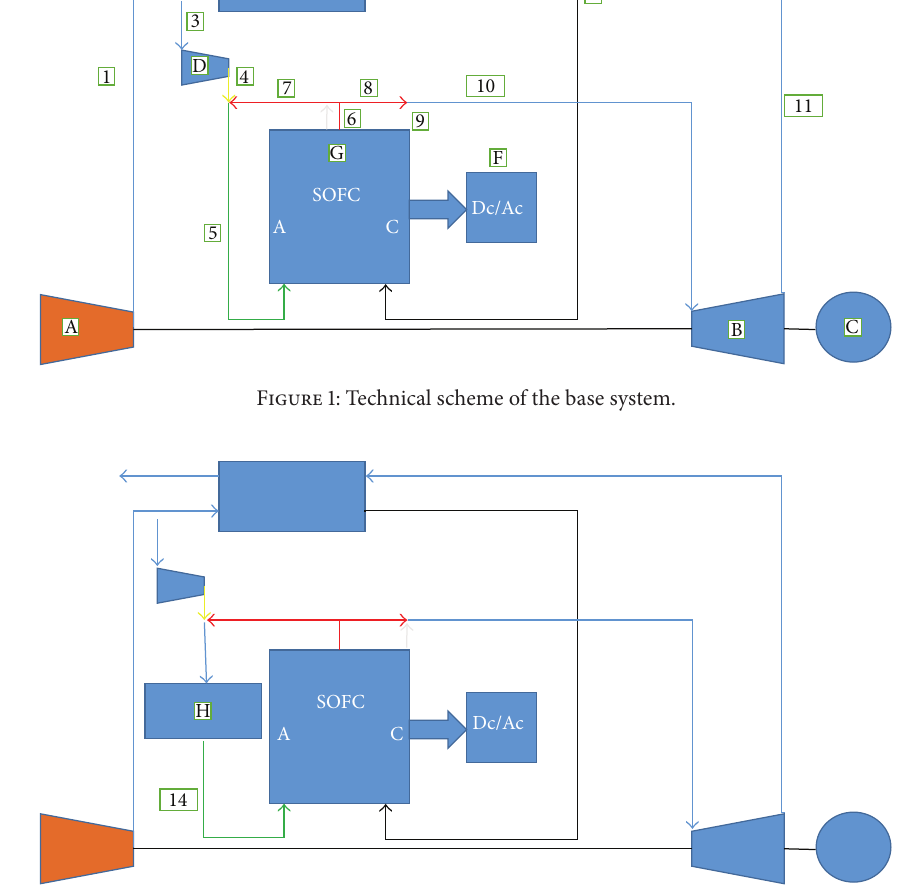
Figure 2: Technical scheme of the system with